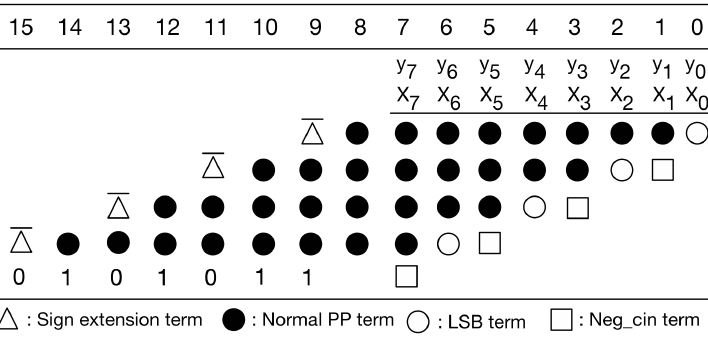
Figure 9. Our simplified PPM.